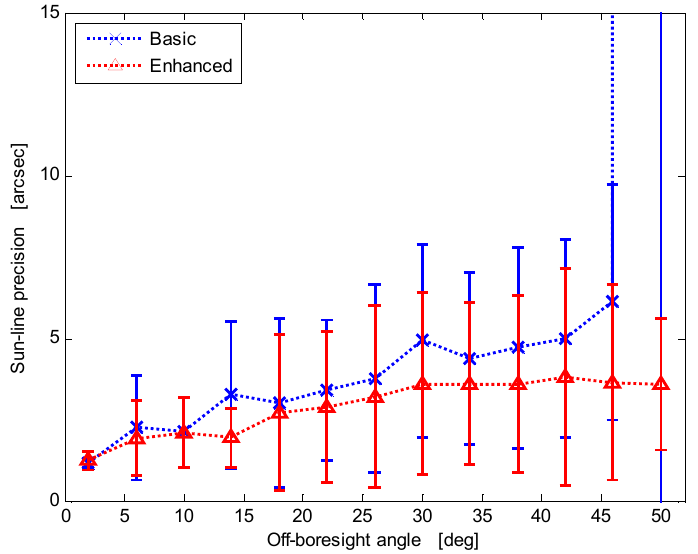
Figure 11. Sun-line predicted precision versus the off-boresight angle for the basic and enhanced